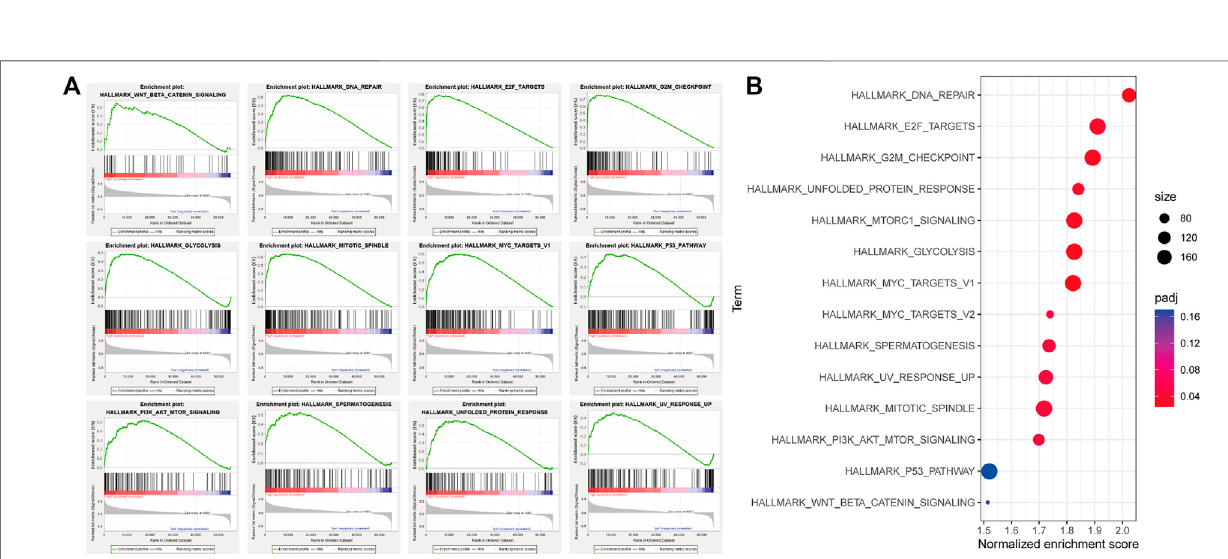
Frontiers in Molecular Biosciences |